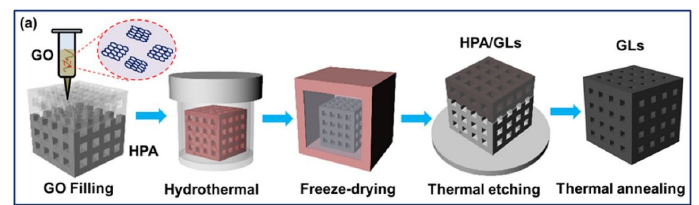
Figure 11. Schematic of 3D graphene lattice fabrication with photocurable hollow polymer architecture. Adapted from [31] with permission, copyright American Chemical Society, 2018.